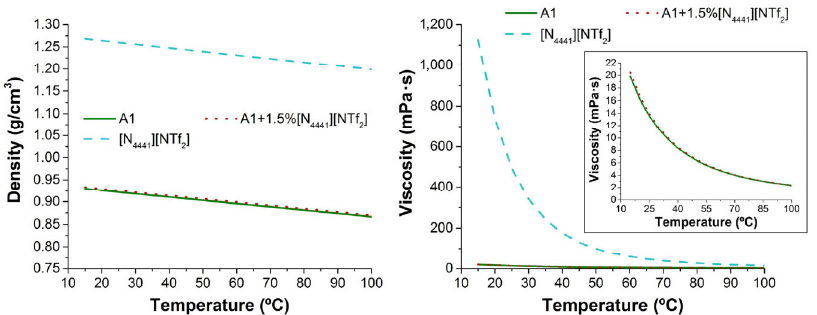
Fig. 1 Density and viscosity versus temperature for the lubricant